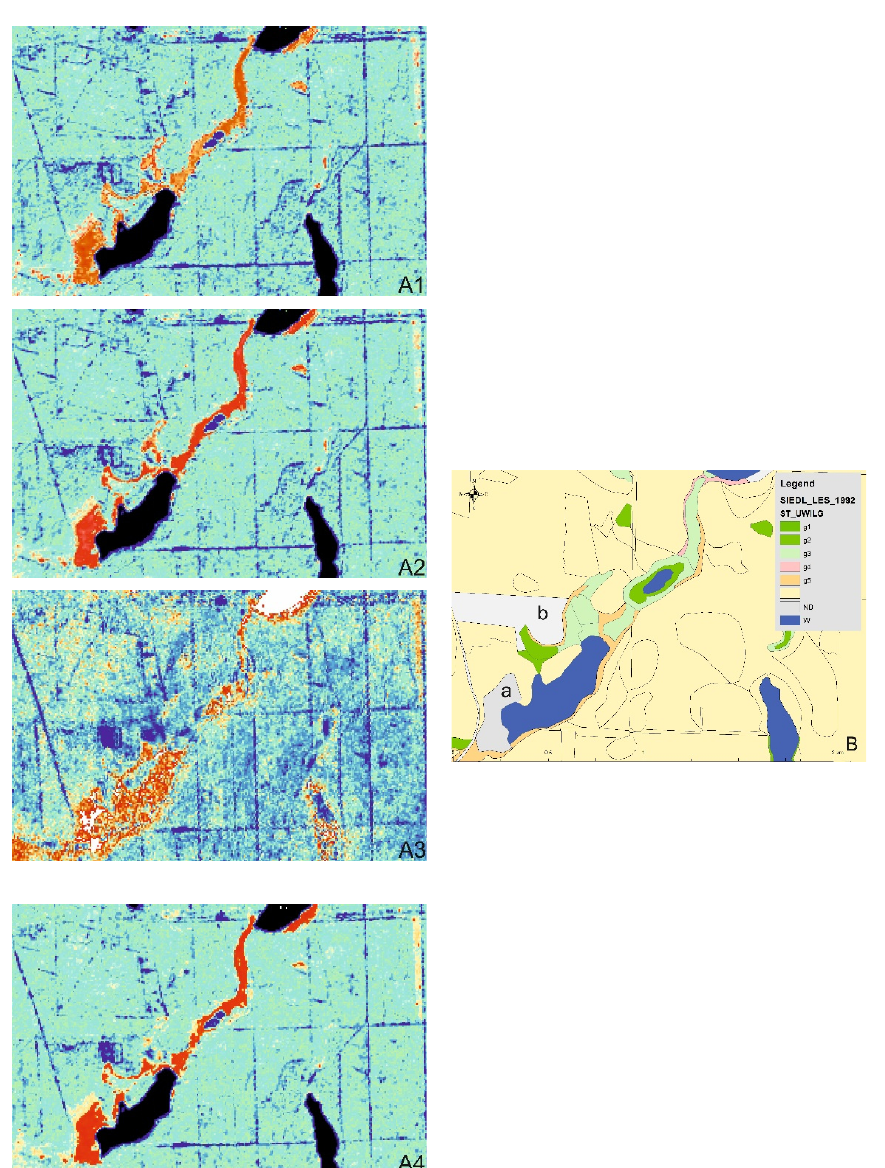
Figure 8. Comparisons of EVI map ( A1 ), SAVI map ( A2 ), SR520/670 map ( A3 ), OSAVI map ( A4 ) with the moisture content map of BTNP ( B ). The letter “a” on the B map indicates a meadow, the letter “b” the private land taken over by the park, for which no habitat development has been carried out, hence there is no data on the degree of moisture content. FHMIs g1 and g2 were combined into one green color .